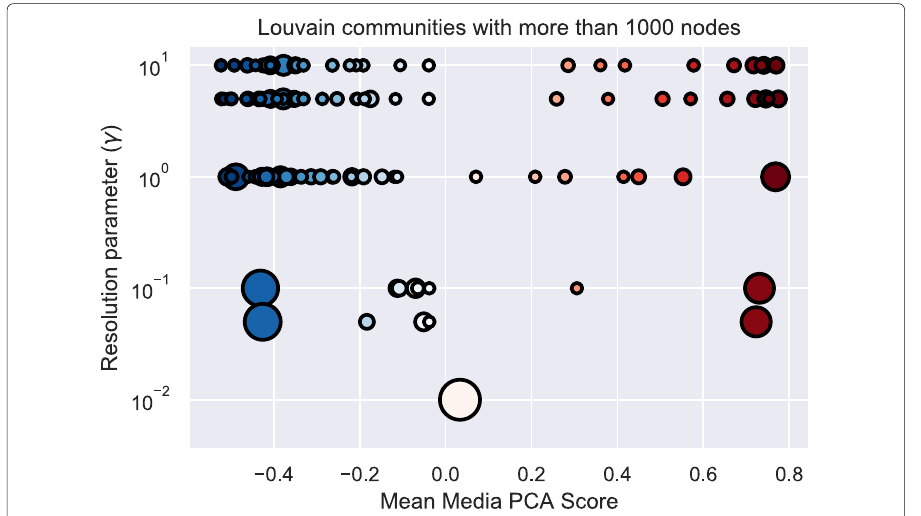
Fig. 5 Modularity maximization results using the G EN L OUVAIN code for several values of the resolution parameter γ (specifically, 0.01,0.05,0.1,1,5, and 10). For each value of γ , we plot communities with at least 1001 nodes versus their mean media PCA score. Colors correspond to the mean media PCA score (with, as usual, ‘Left’ signifying negative values and ‘Right’ signifying positive values), and disk size corresponds to the number of nodes in a community. For all explored values of γ that result in more than one community, we detect more large communities (i.e., those with at least 1001 nodes) on the Left than on the